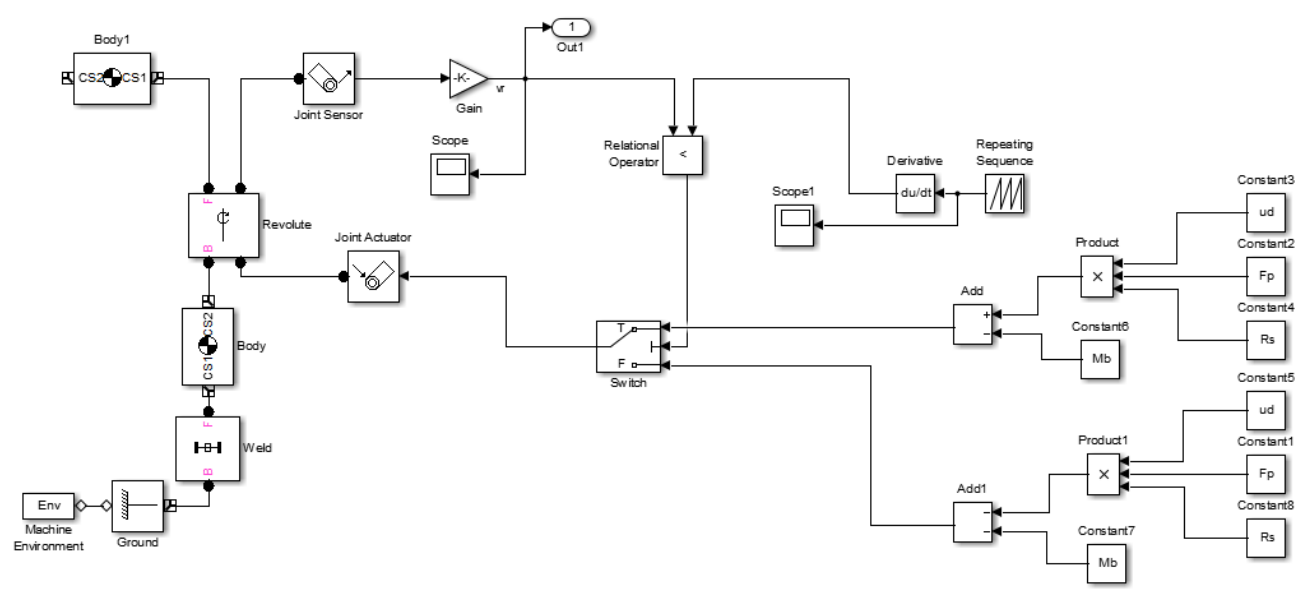
Figure 4. Simulink model of the proposed panoramic scanning imaging actuator.